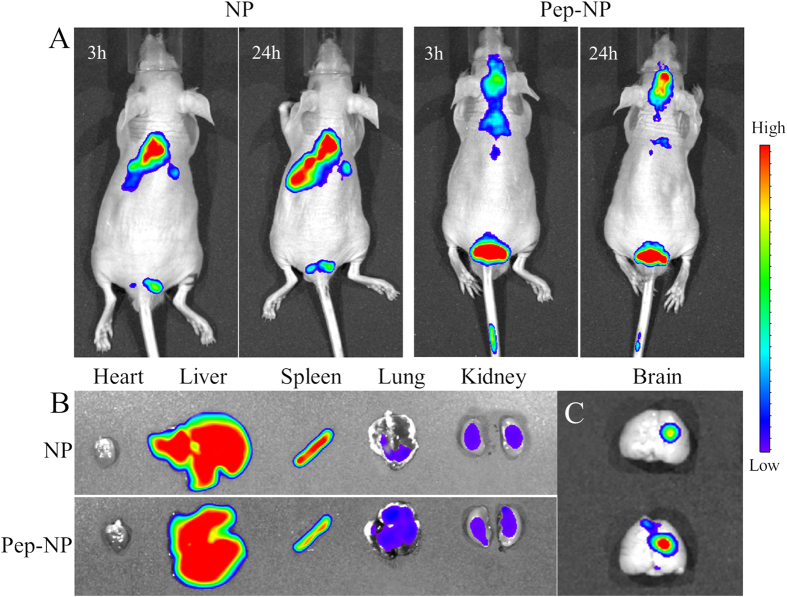
In vivo fluorescence imaging of intracranial C6 glioma-bearing nude mice after intravenous injection of Dir-labeled nanoparticles (A).Image of the tissues (B) and brains (C) sacrificed 24 h after intravenous injection of nanoparticles.